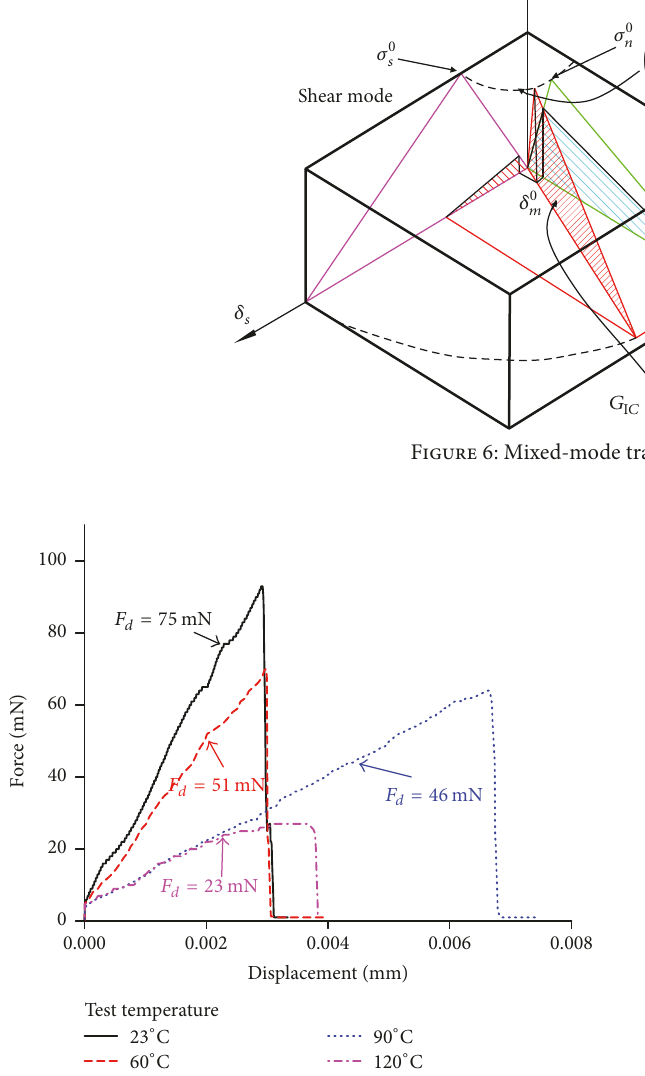
Figure 7: Force-displacement curves under different tested temper- ature by experiment results.